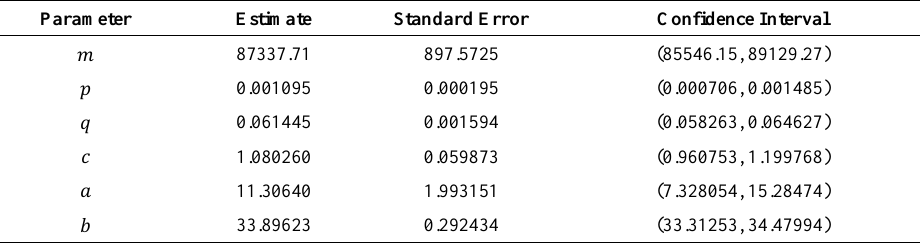
Table A8. Lombardy. Estimates, asymptotic standard errors and 95% mCIs for the parameters of the GBM 𝑹𝑬𝑪𝑻 (4)+(5).